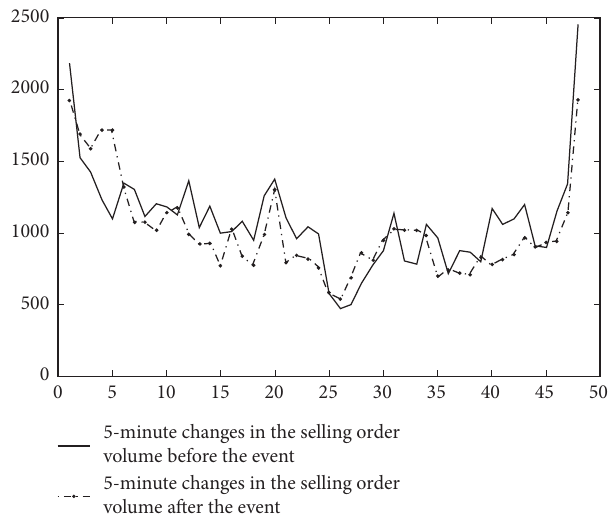
Figure 5: The intraday changes in the selling order volume for the IC dominant contract (five